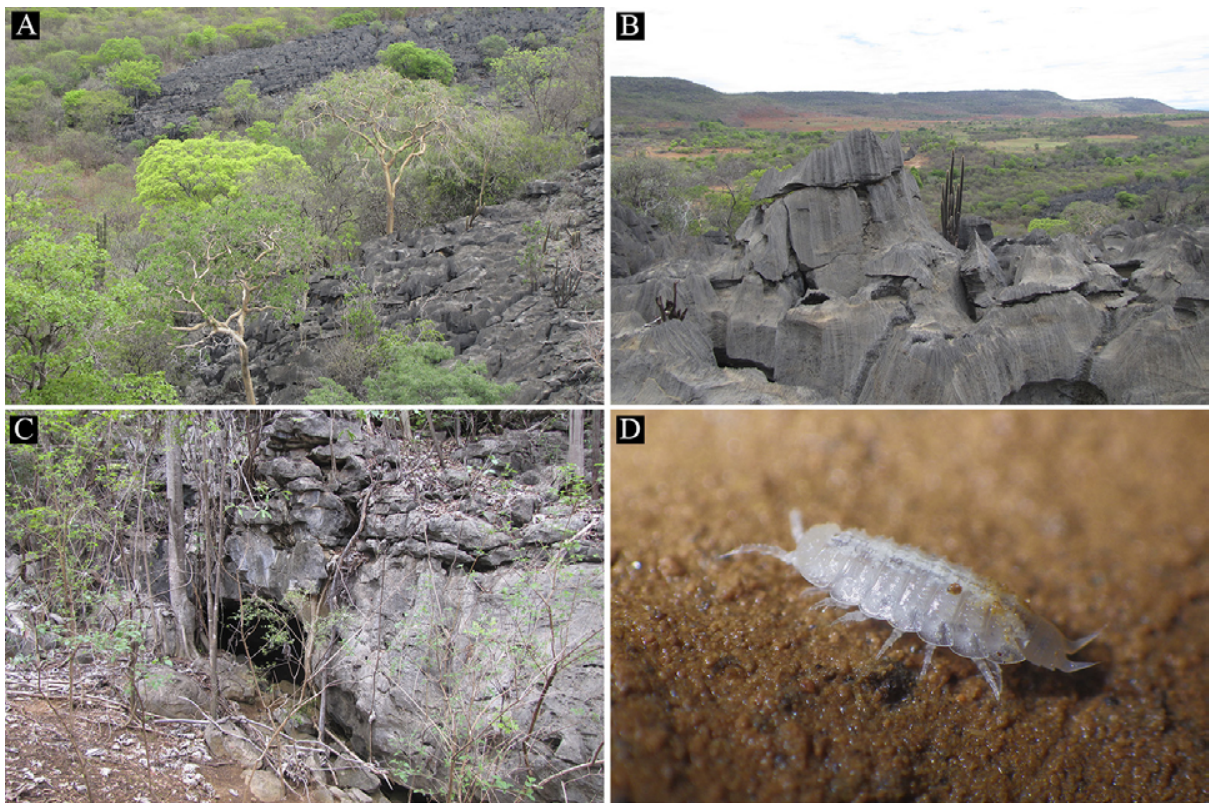
Figure 10. Pectenoniscus iuiuensis n. sp. A , surroundings of Baixa da Fortuna cave; B , landscape around Serra de Iuiú; C , entrance of Baixa da Fortuna cave; D , specimen of Pectenoniscus iuiuensis n. sp., approximately 3